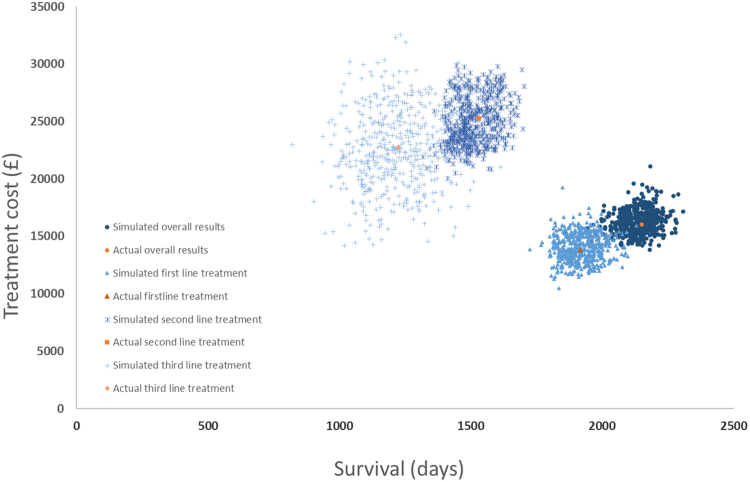
Model validation.